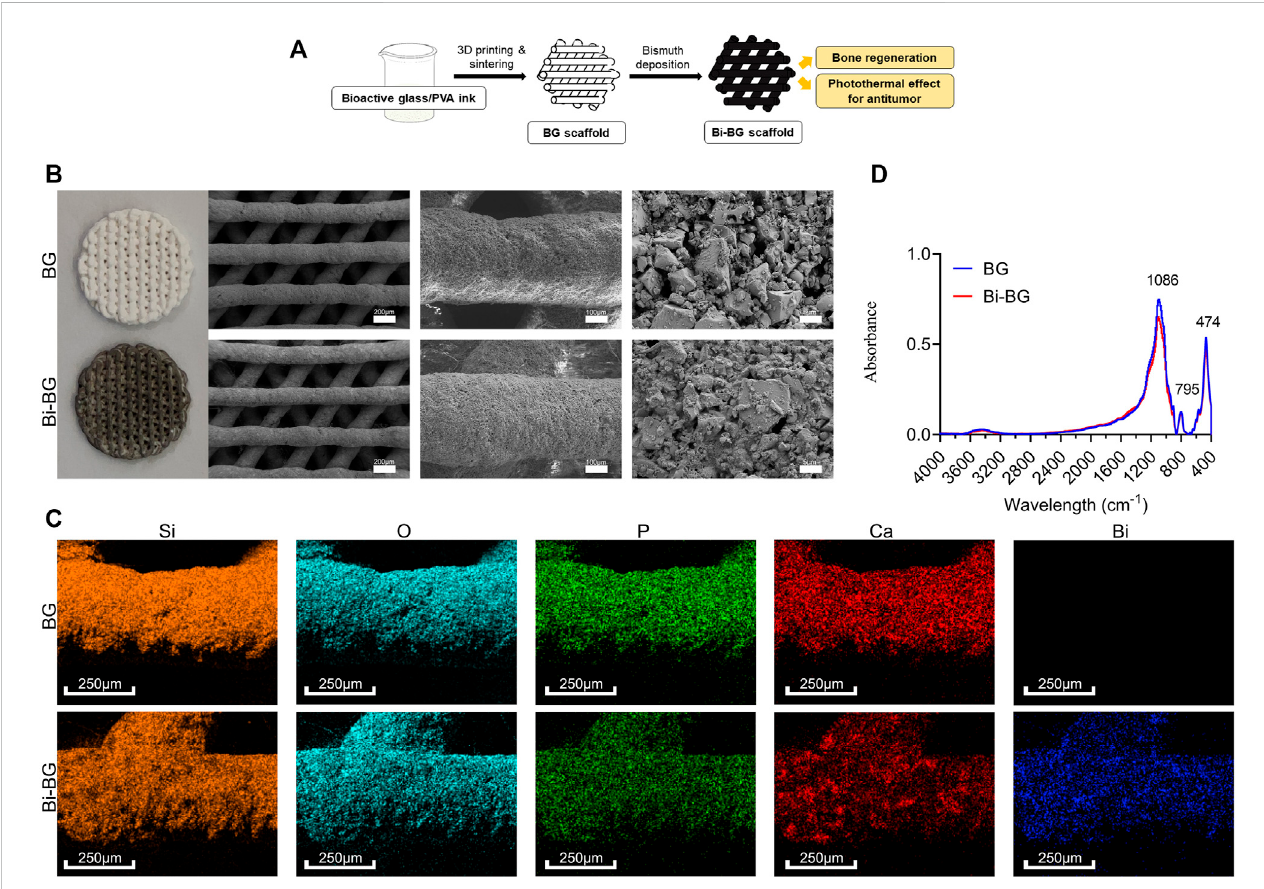
FIGURE 1 Fabrication and characterizations of BG and Bi-BG scaffolds. (A) Schematic illustration for the formation of bifunctional Bi-BG scaffolds. (B) Photograph and SEM images of 3D printed pure BG and Bi-BG scaffolds; (C) Elemental mapping images (Si, O, P, Ca, and Bi elements) of BG and Bi-BG scaffolds; (D) FTIR patterns of the